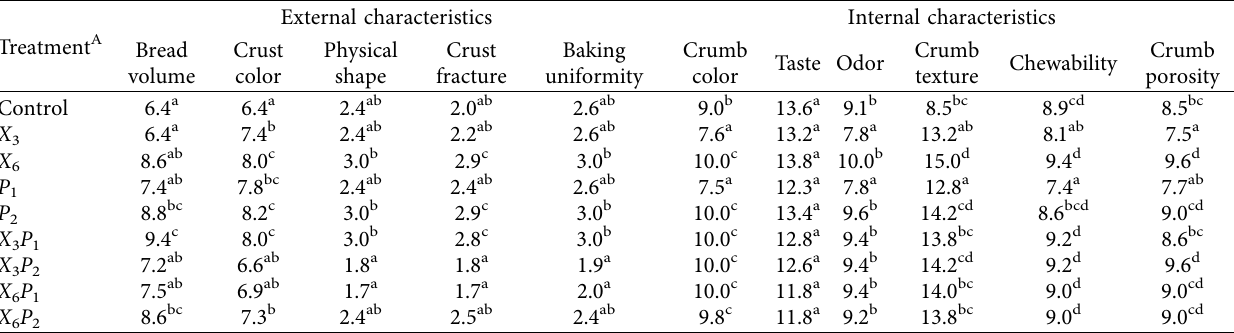
Table 7: External and internal characteristics of baguette bread samples. Treatment